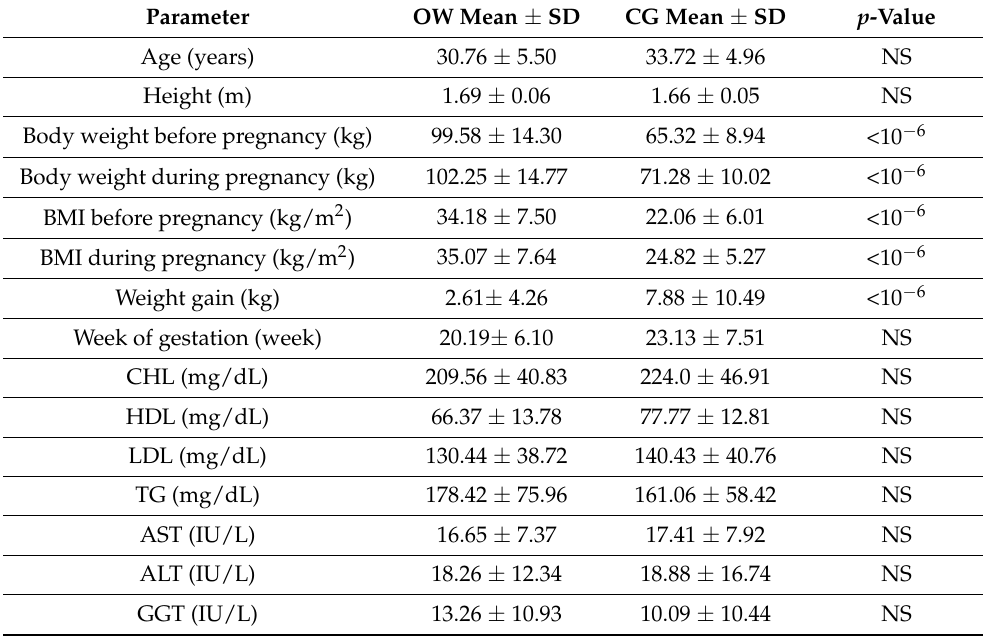
Table 1. Demographic, anthropometric, and biochemical features of OW and CG subjects. The mean and standard deviation of each variable are